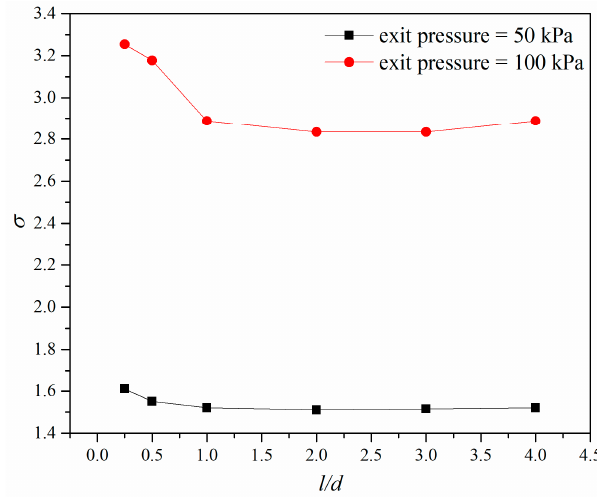
Figure 8. Cavitation number under different exit pressure for the same pressure difference.